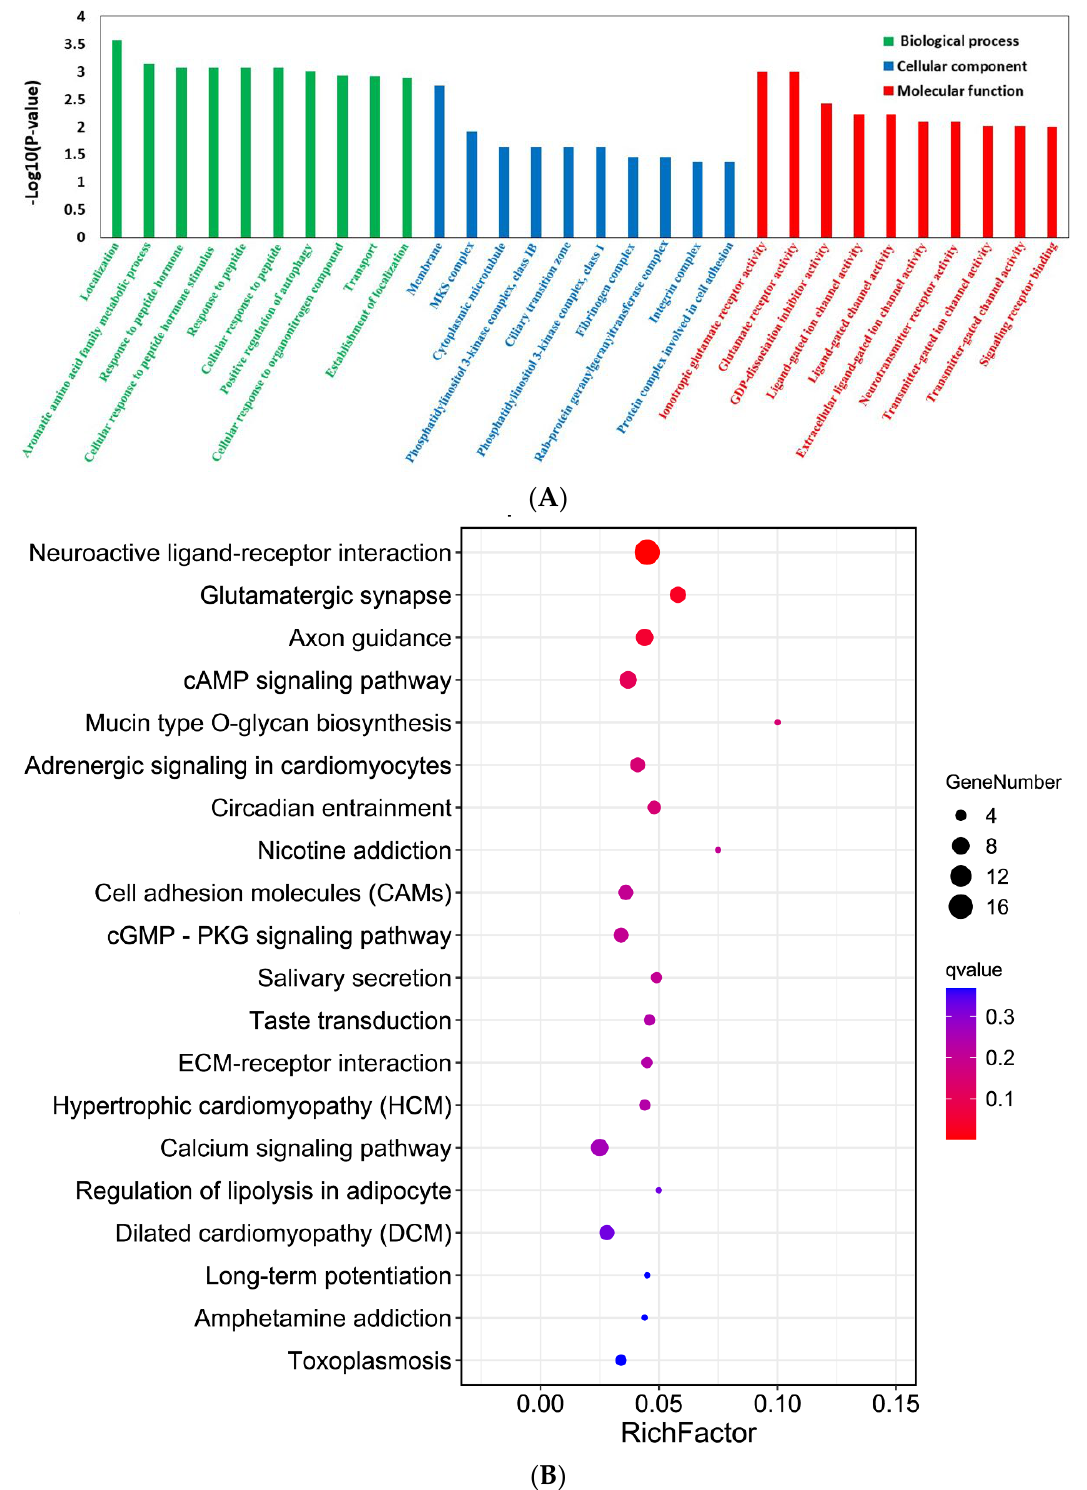
Figure 10. GO and KEGG analyses revealed the biological information of YTHDF1-knockout